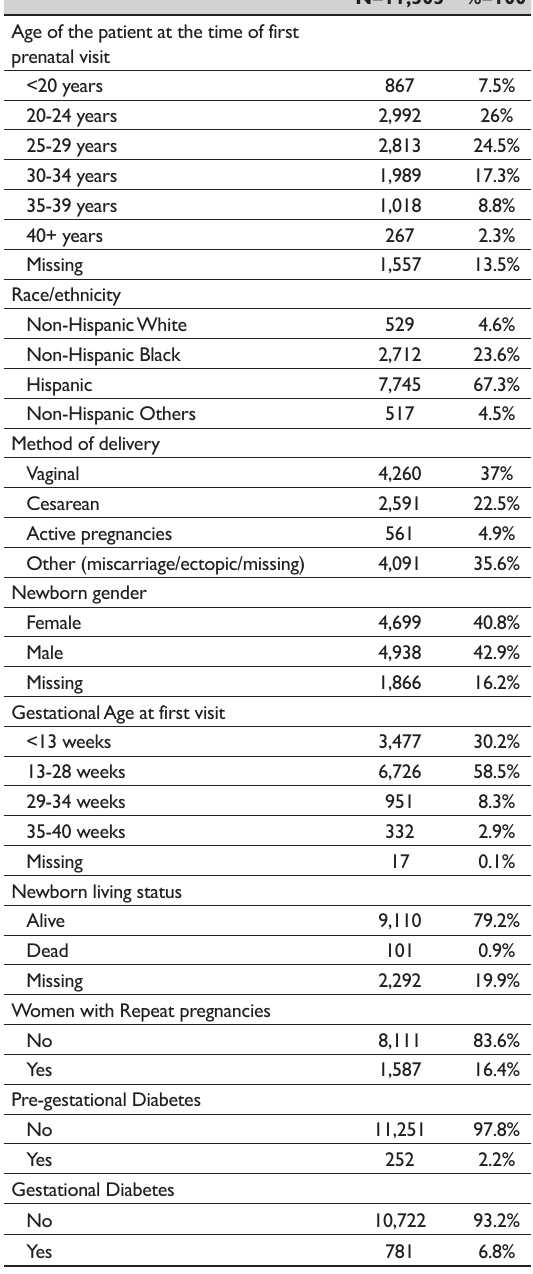
Table 1: Patient demographic, comorbid